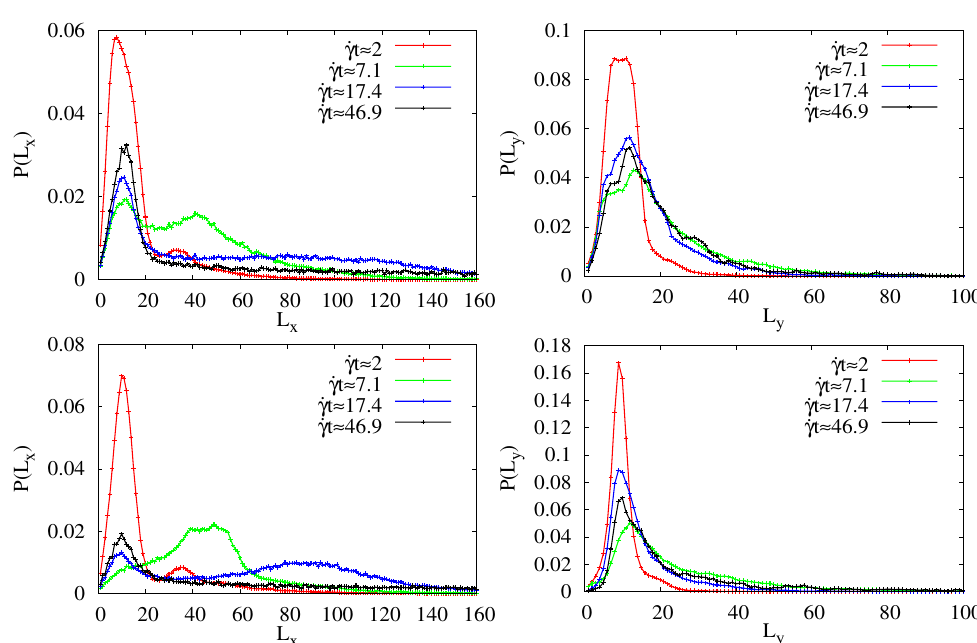
Figure 8. Probability distribution functions P of domains of length L x ( left panels) and L y ( right panels) with λ = 3 ( upper row) and λ = 0 ( lower row) in the strong shear